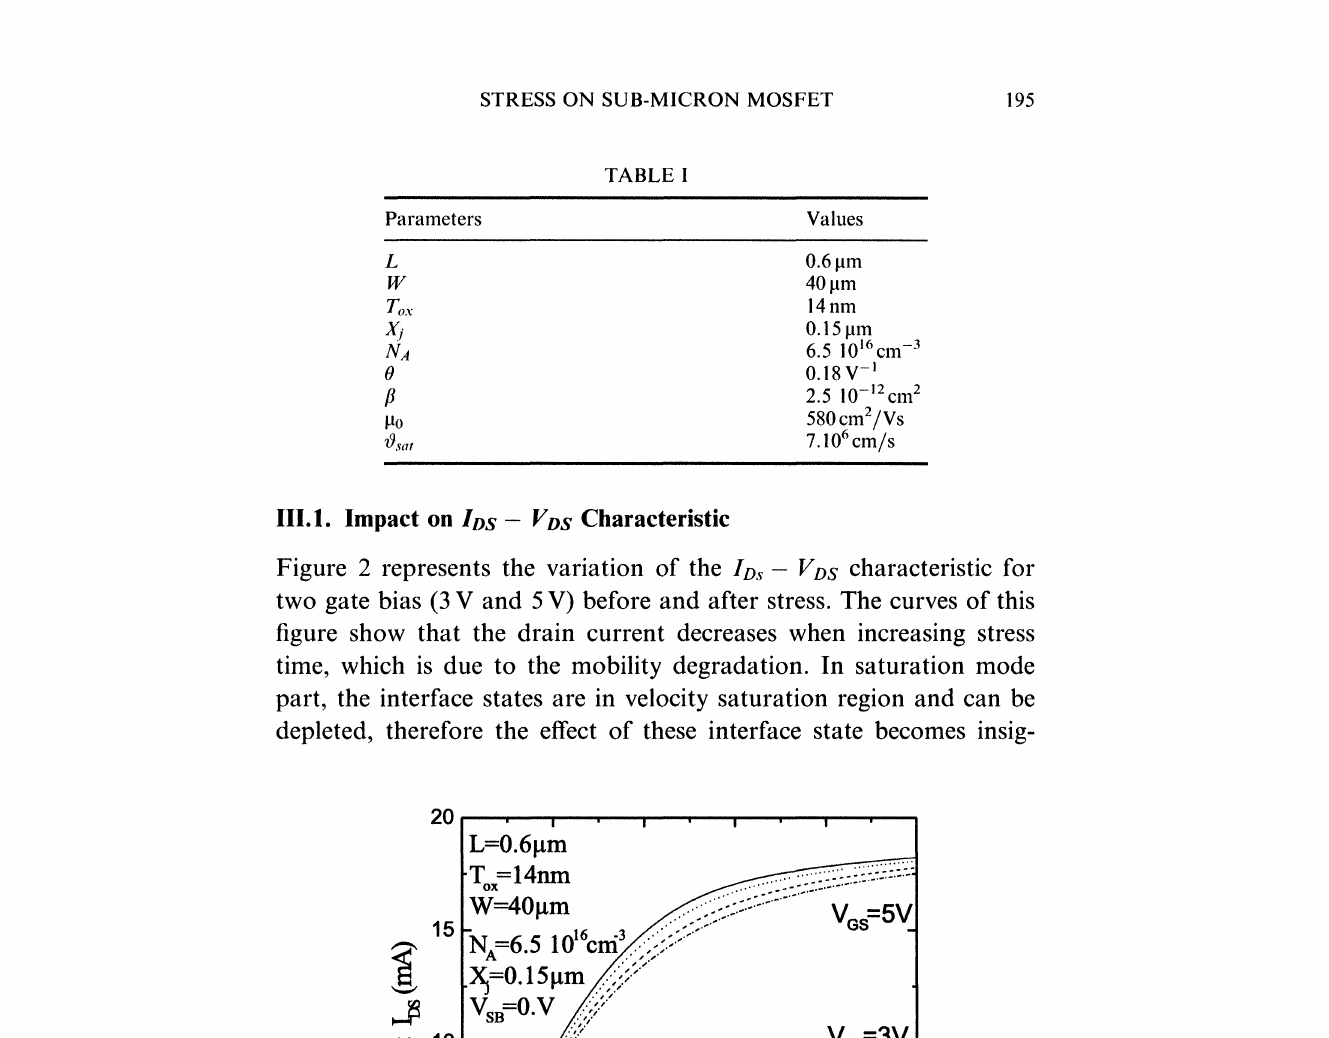
FIGURE 2 Variation of the los- VDs characteristic versus stress